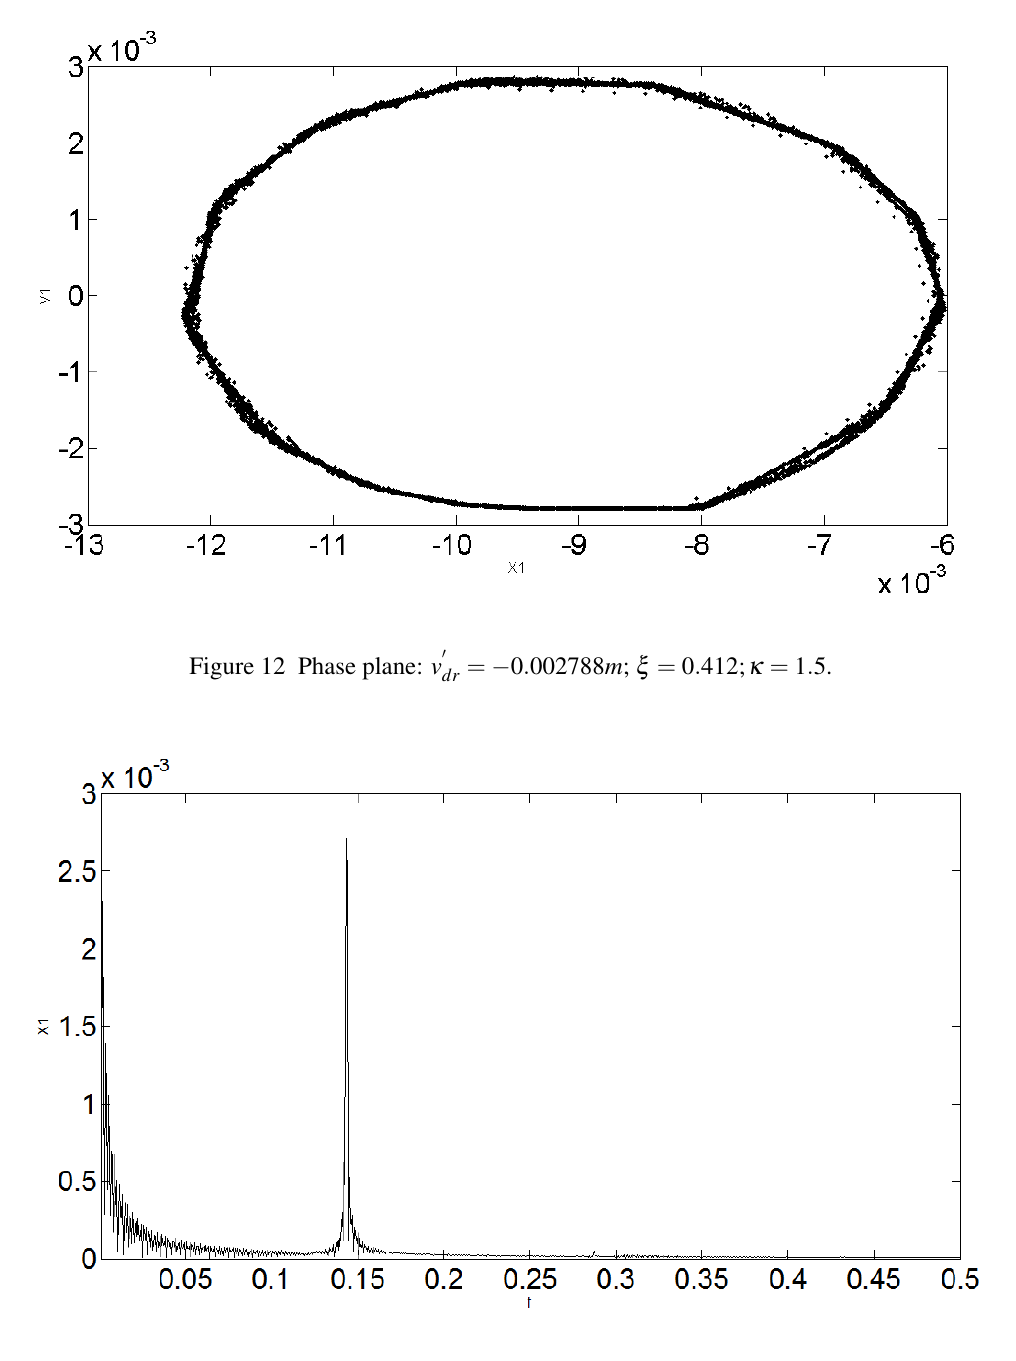
= − 0 . 002788 m ; ξ = 0 . 412; κ = 1 . dr